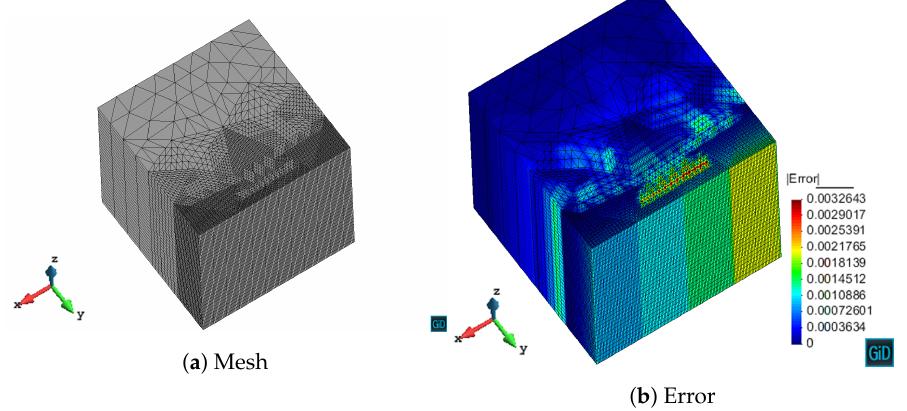
Figure 7. Refinement with criteria for not allowing neither eyes nor elements with an angle lower than 0.4 rad.